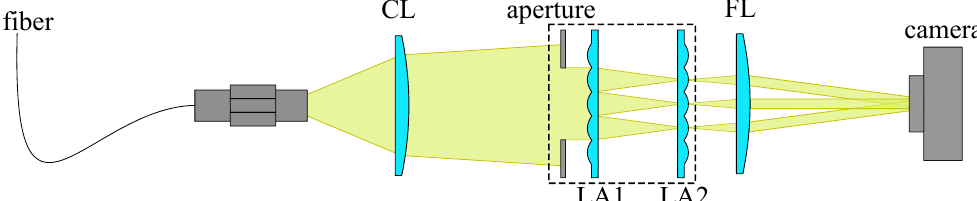
Figure 4. Schematic of experimental setup including a halogen light source, a collimator lens (CL), an iris diaphragm/ aperture, the two lens arrays (LA1 & LA2), a Fourier lens (FL) and a camera. The dashed box marks the beam homogenizer used in one